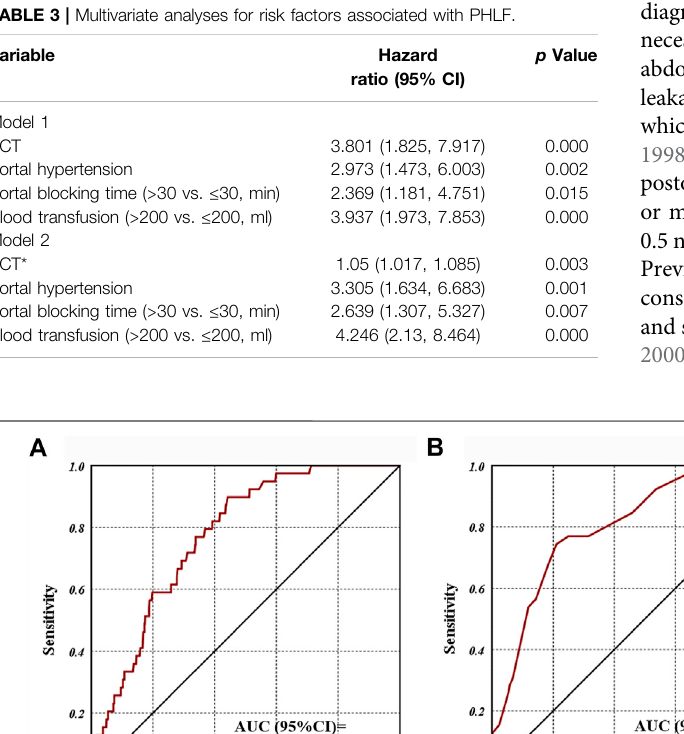
The bold values represent the statistical signi fi cance of the data.